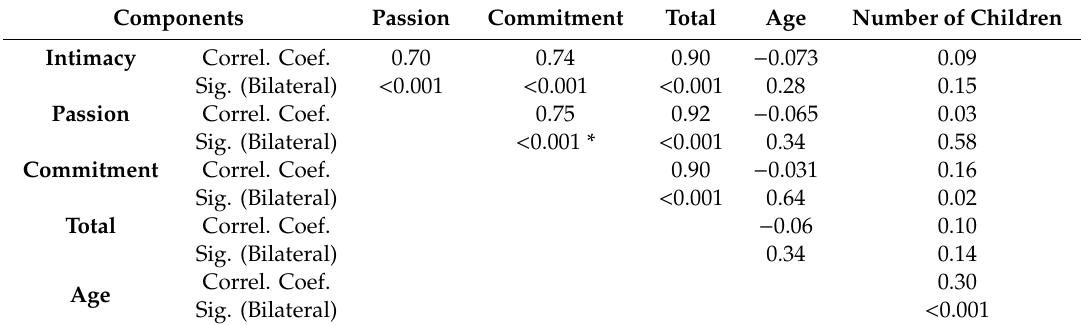
Table 8. Correlations between the total components’ scores, age, and number of children. Components Passion Commitment Total Age Number of Children Intimacy Correl. Coef. Correl. Coef.